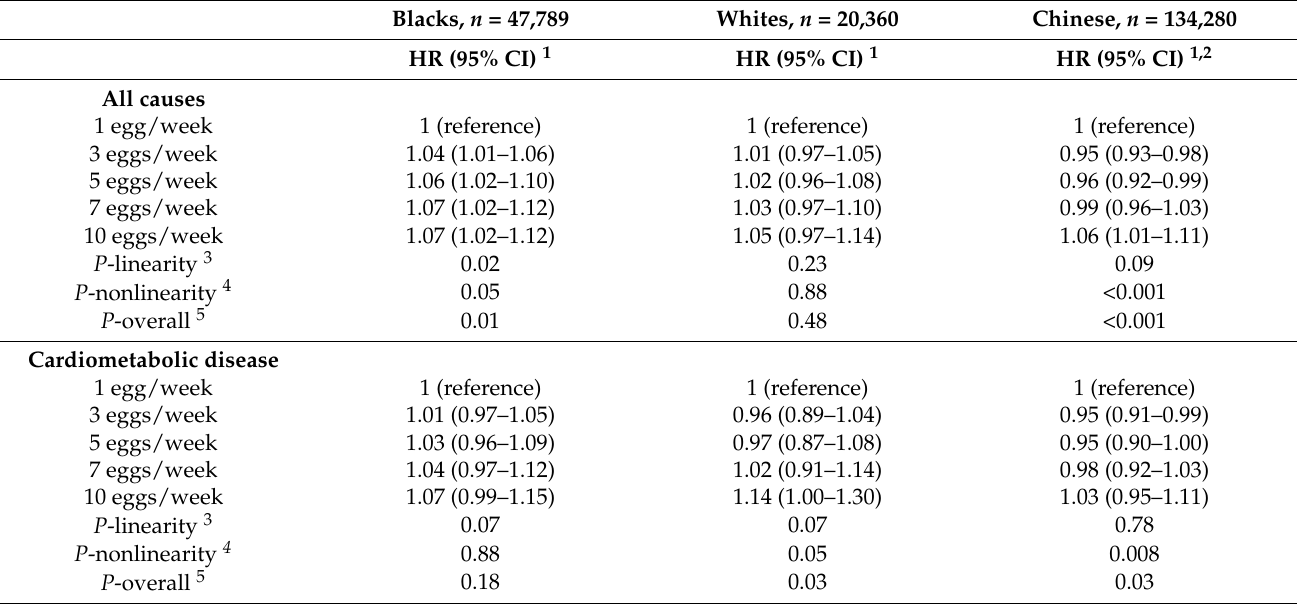
Table 3. All-cause and cause-specific mortality in relation to egg intake. Blacks, n = 47,789 Whites, n = 20,360 Chinese, n =